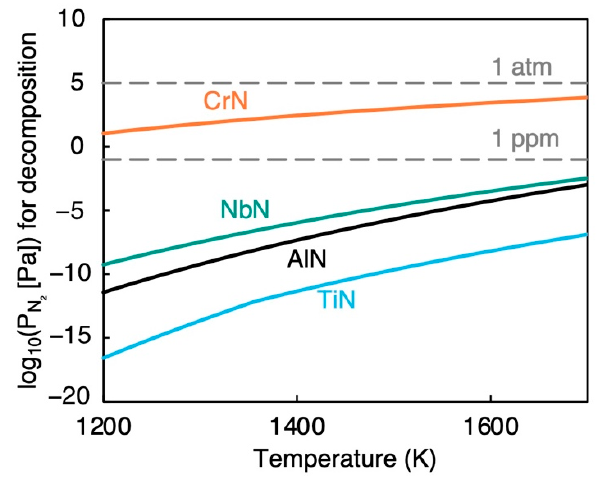
Figure 18. Simulated N 2 partial pressure for nitride decomposition as a function of temperature.